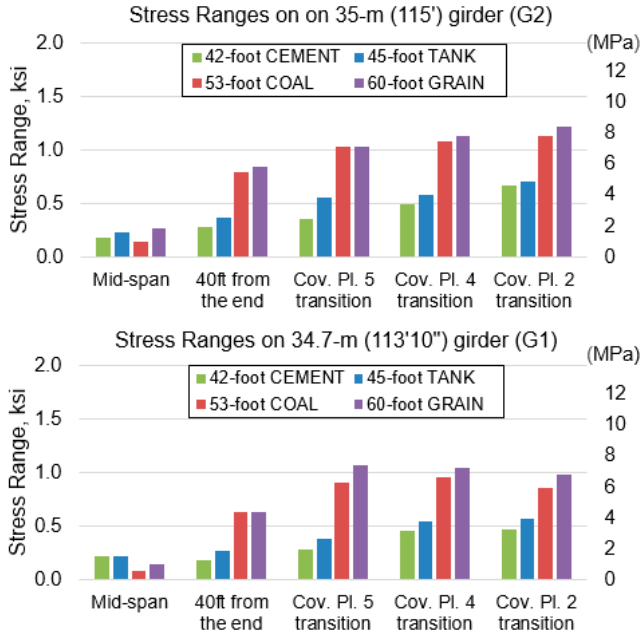
Figure 22. Stress range calculated from measured strains—comparisons for girder G1 and G2.